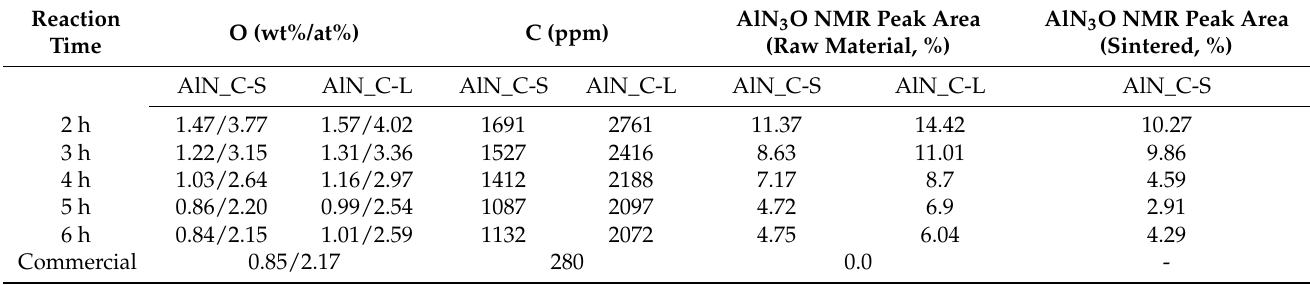
Figure 2. XRD patterns for ( a ) raw materials (AlN_C-S, AlN_C-L), ( b ) sintered AlN_C-S samples, and ( c ) sintered AlN_C-L samples. As carbothermal reaction exceeds 1 h, peaks due to aluminum oxide in raw materials disappear as a result of reduced oxygen. As carbothermal reaction time increases, a second phase of YAG changes to YAP and YAM in the XRD patterns of sintered samples. Table 1. Chemical analysis and NMR fitting results of AlN raw